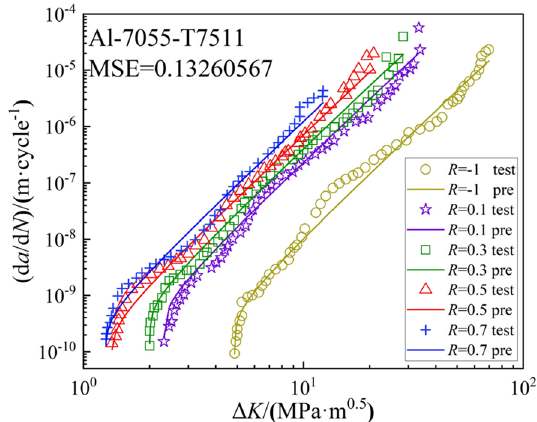
Figure 7 SR model predicting curves and test data about Al-7055-T7511